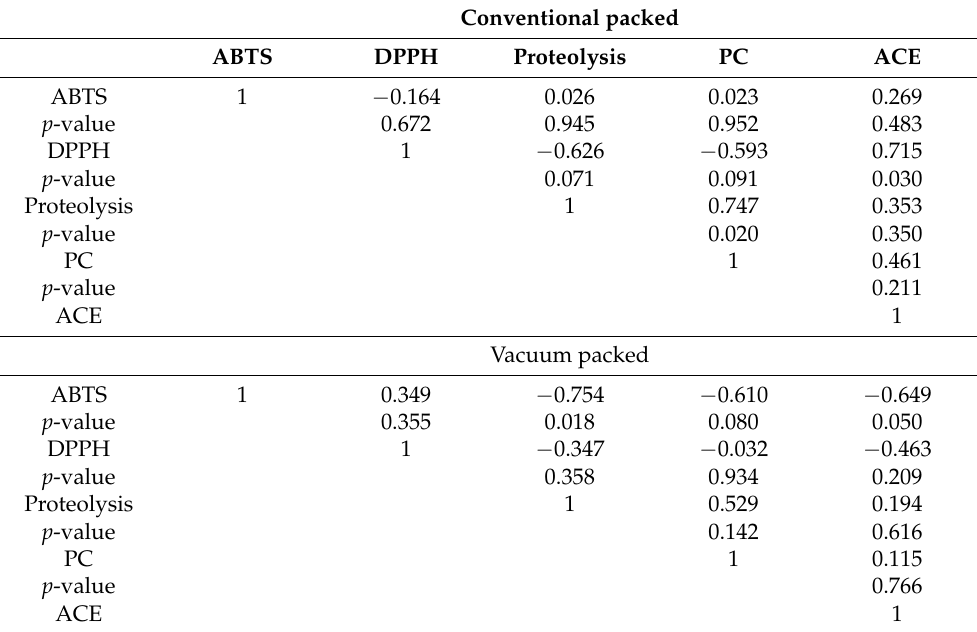
Table 3. Correlation between response variables of T3 requeson cheese (1.5% NACl).